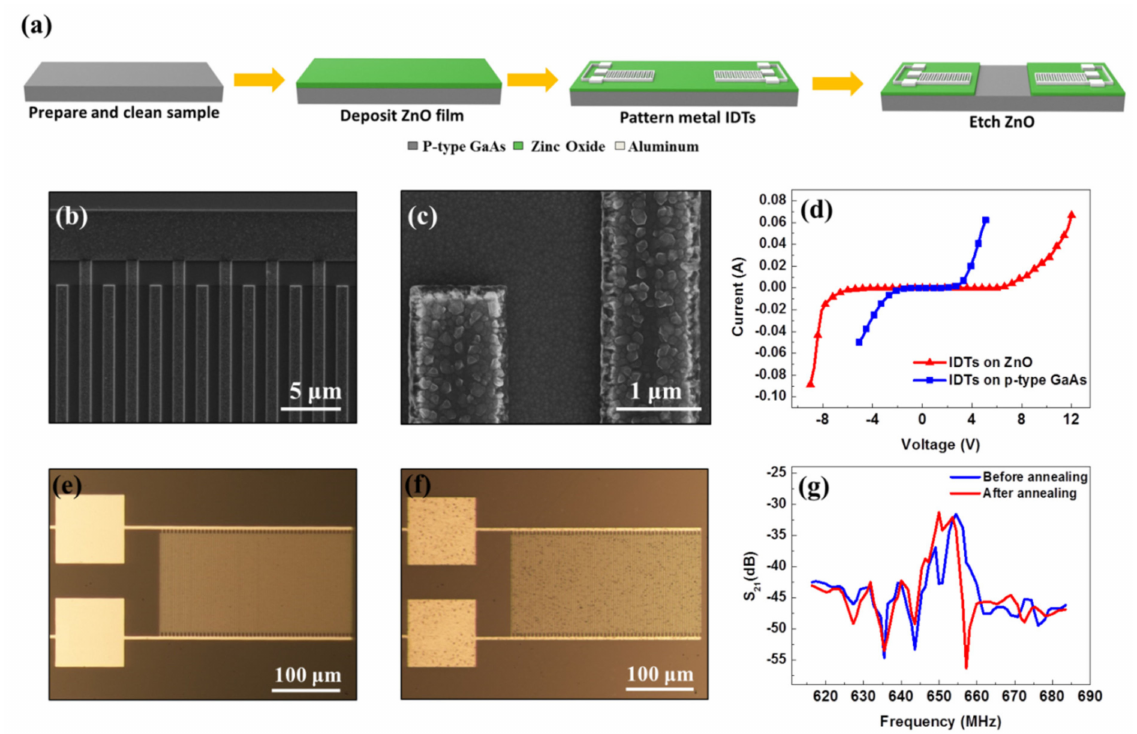
Figure 4. ( a ) Fabrication process flow of the device: deposition of ZnO thin layer, e-beam lithography and e-beam metal evaporation for aluminum IDTs, etch ZnO to open a window for exposing GaAs surface in center. ( b ) Scanning electron microscope (SEM) image of the top surface view of IDT fingers placed on the ZnO film. ( c ) High-resolution SEM image showing the surface morphology of the aluminum IDT finger and the c-axis oriented ZnO layer. ( d ) Current–voltage (I–V) characteristics of IDTs fabricated on di ff erent materials. ( e ) Optical microscope images of the IDTs taken before annealing. ( f ) Optical microscope images of the IDTs taken after annealing. ( g ) Comparison of transmission property S 21 of SAWs generated before and after